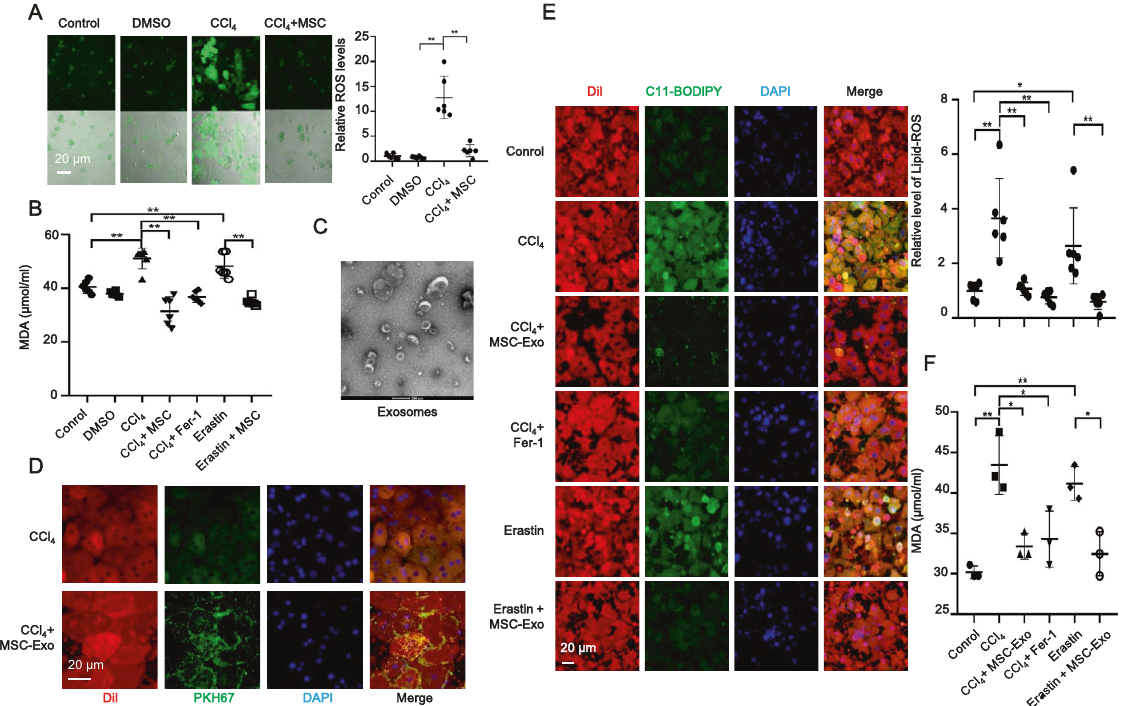
Fig. 4 MSC-Exo mediated the effect of MSCs against CCl 4 -induced ferroptosis in vitro. A Relative ROS levels were measured by H 2 DCFDA staining in primary hepatocytes treated with control (PBS), dimethyl sulfoxide (DMSO), or 10 mM CCl 4 for 48 h with or without MSCs coculture. B The increased MDA level induced by CCl 4 was downregulated by MSCs coculture and Fer-1 treatment in primary hepatocytes. The increased MDA level induced by erastin was also downregulated by MSCs coculture in primary hepatocytes. C Refrigerated transmission electron microscopy was used to assess exosomes isolated from MSCs. D Exosomes collected from MSC-conditioned medium were labeled with PKH67 and incubated with CCl 4 -induced acute injured hepatocytes for 24 h. The cell membrane was stained with Dil. The nuclei were stained with DAPI. PKH67 lipid dye was detected in damaged hepatocytes treated with PKH67-labeled exosomes in the CCl 4 group. E Isolated hepatocytes were incubated with C11-BODIPY 581/791 and then analyzed by using laser confocal focus. Cell membrane was stained with Dil. The nuclei were stained with DAPI. C11-BODIPY 581/591 staining showed a signi fi cant increase in lipid peroxidation in hepatocytes following CCl 4 and erastin treatment, while MSC-Exo and Fer-1 downregulated the increased lipid peroxidation induced by CCl 4 and erastin. F The increased MDA level induced by CCl 4 and erastin were downregulated by MSC-Exo and Fer-1 treatments in primary hepatocytes. Signi fi cance was calculated by one-way ANOVA with Tukey ’ s post hoc test. * p < 0.05 or ** p < 0.001 indicated a signi fi cant difference between